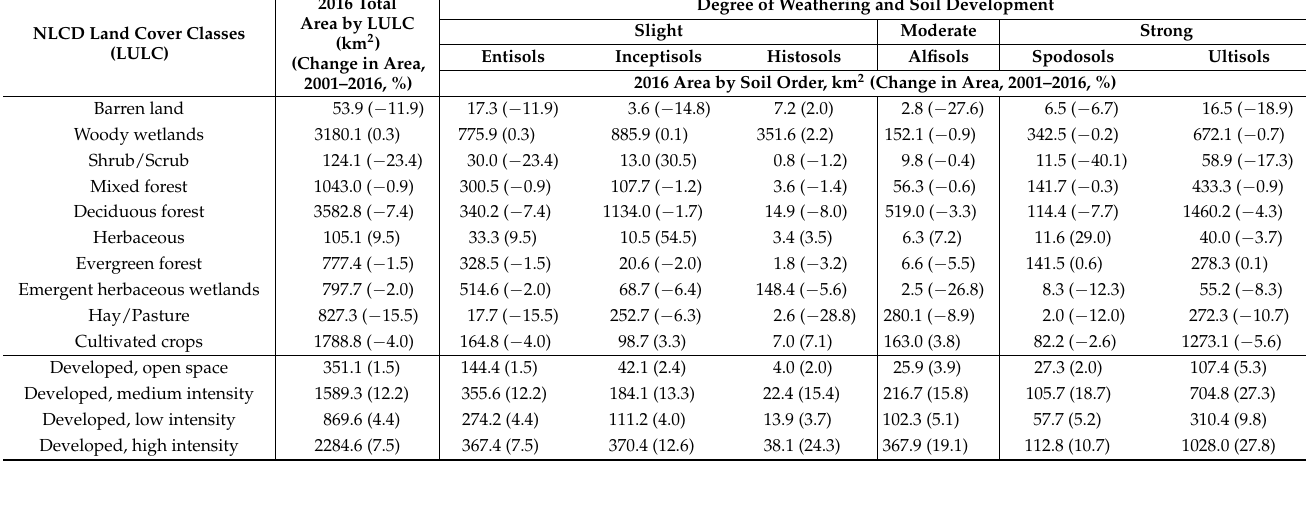
Table 8. Change in land use/land cover (LULC) by soil order in New Jersey (USA) from 2001 to 2016.